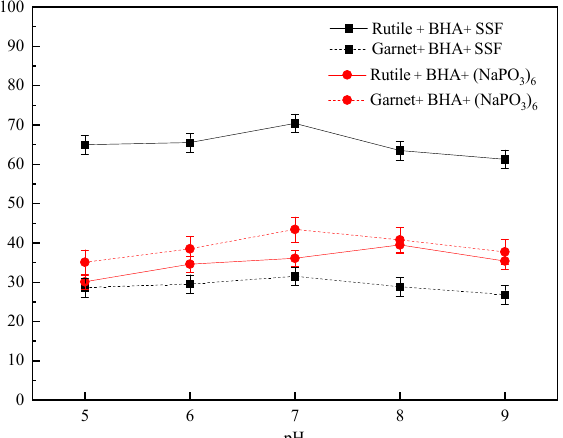
Figure 5. Effect of pH on the flotation of rutile and garnet by SSF and (NaPO 3 ) 6 (concentration of BHA = 20 mg/L, concentration of SSF = 10 mg/L, concentration of (NaPO 3 ) 6 = 10 mg/L).